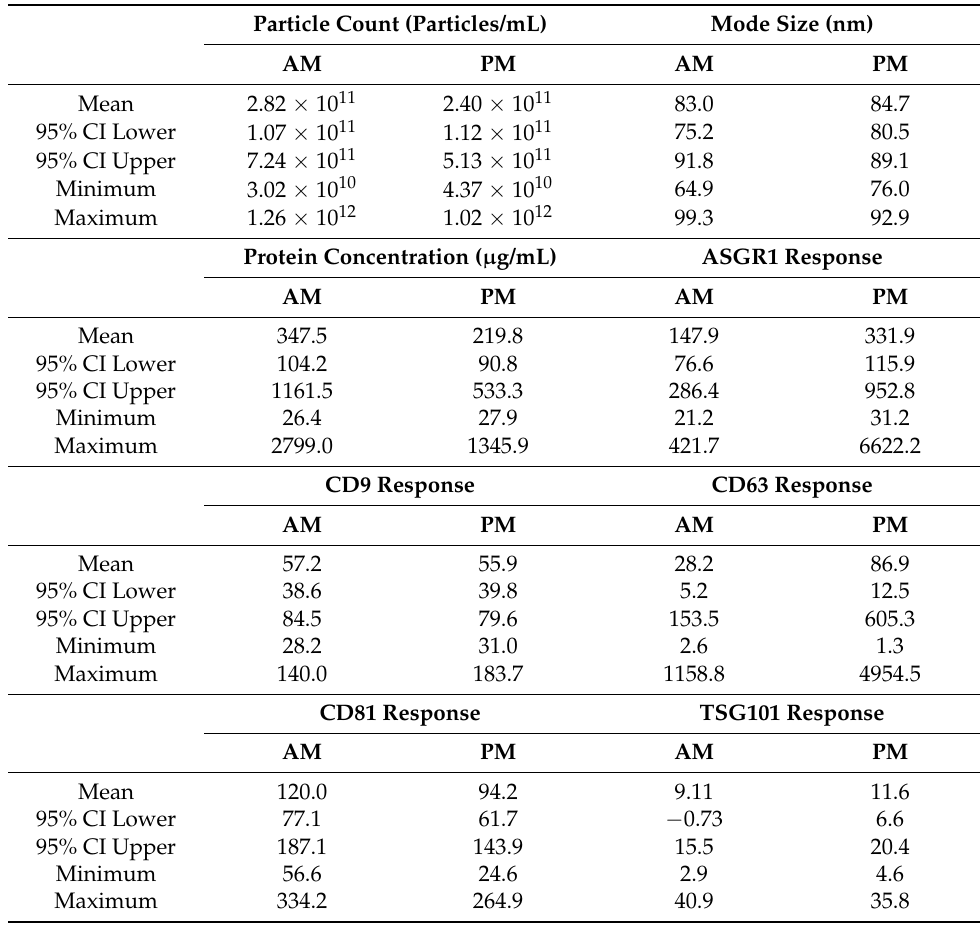
Table 2. Geometric mean, 95% confidence interval (CI), minimum and maximum of particle count, mode size, total protein concentration, and EV-associated protein marker abundance quantified in EVs isolated in the morning and afternoon on study day 1 from serum of healthy volunteers ( n = 10). Particle Count (Particles/mL) Mode Size